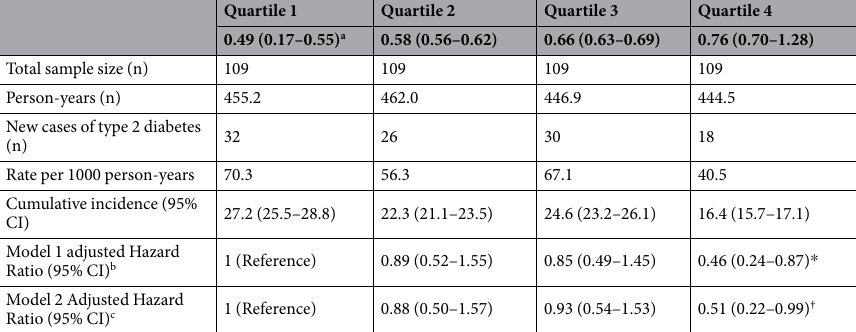
Table 3. Cumulative incidence of T2DM by quartiles of cholesterol efflux/apoA-I ratio. a Median (Intertertil